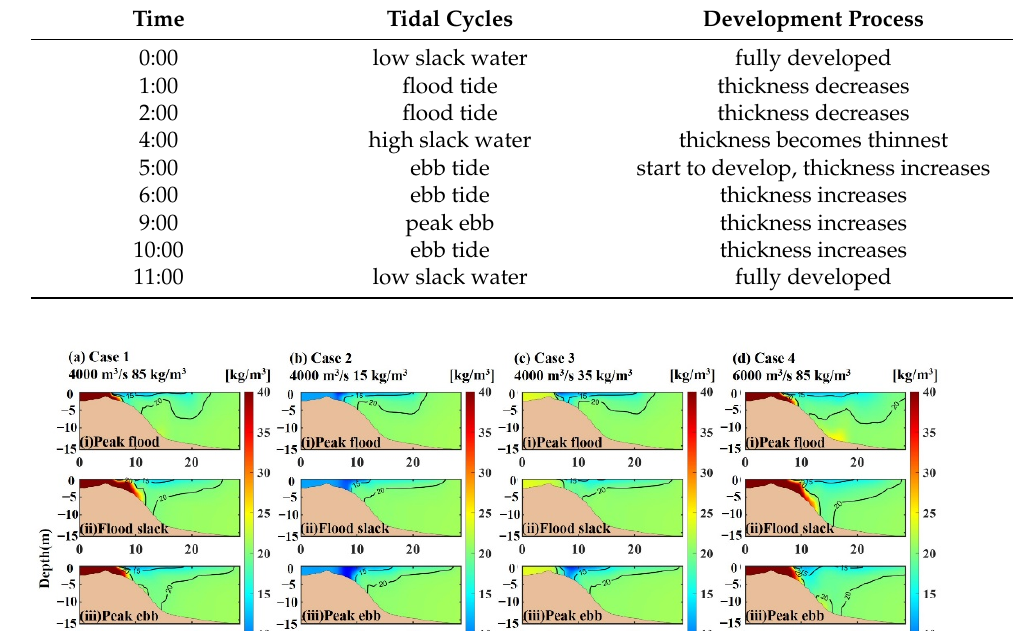
Table 5. Details of the numerical experiments.